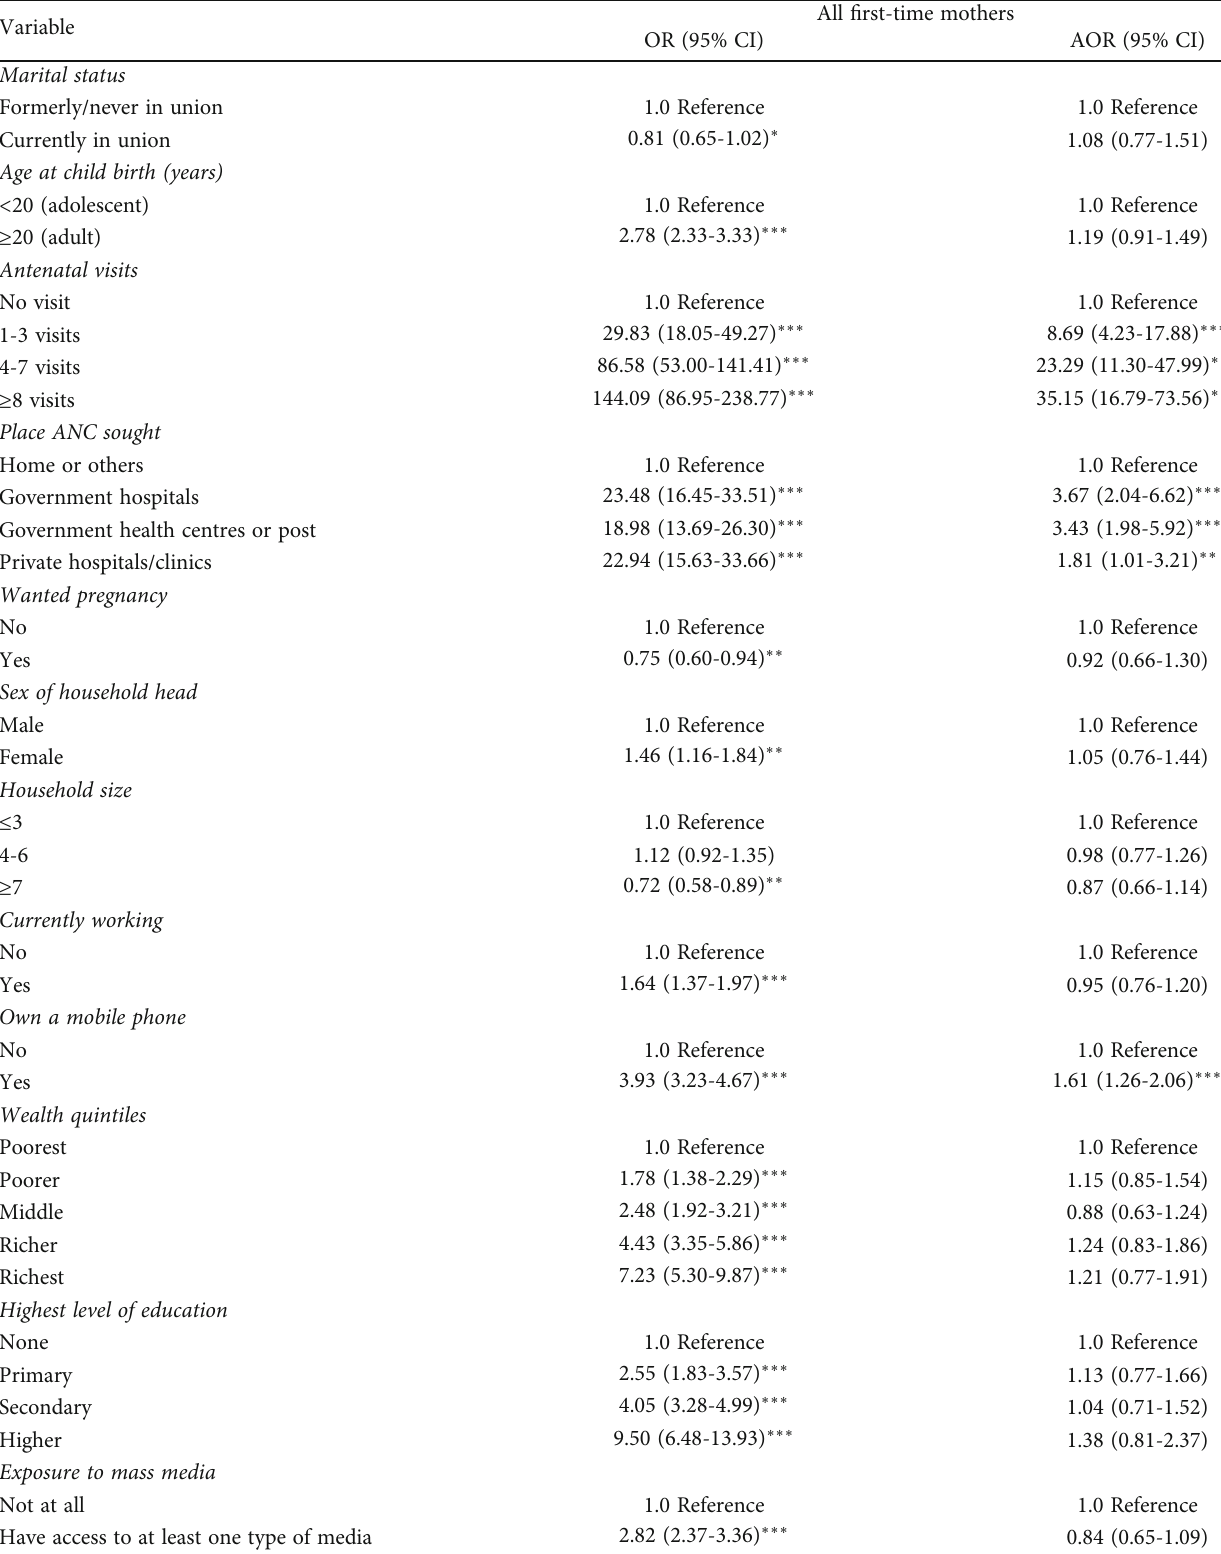
Table 3: Crude and adjusted ordinal logistic regression of fi rst-time mothers who took at least two doses of